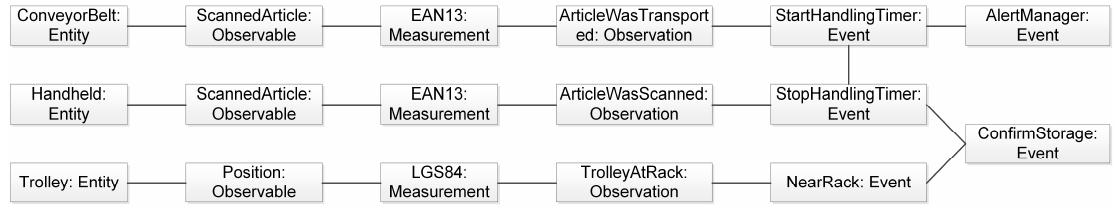
Figure 14. Activity diagram of the storage use case example with exception-related events.